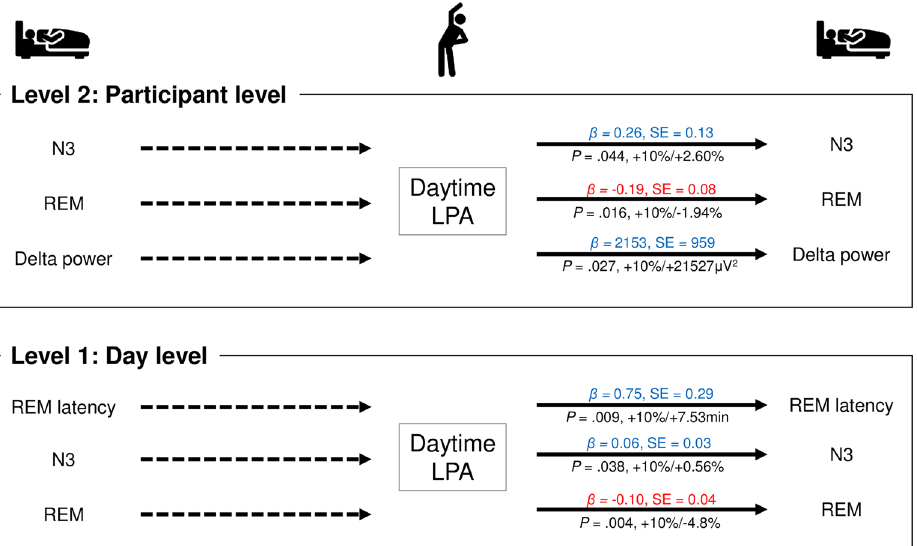
Figure 3. Bidirectional associations between sleep parameters and low-intensity physical activity. Adjusted for age; sex; BMI; history of smoking, alcohol consumption, and caffeine consumption; and medical history of hypertension, hyperlipidemia, and depressive symptoms. LPA low-intensity physical activity. The solid line represents significant relevance. A solid line on both sides indicates bidirectionally related parameters, and a solid line on one side and a dashed line on the other side indicate only temporally related parameters. Blue text indicates a positive relationship, and red text indicates a negative relationship.